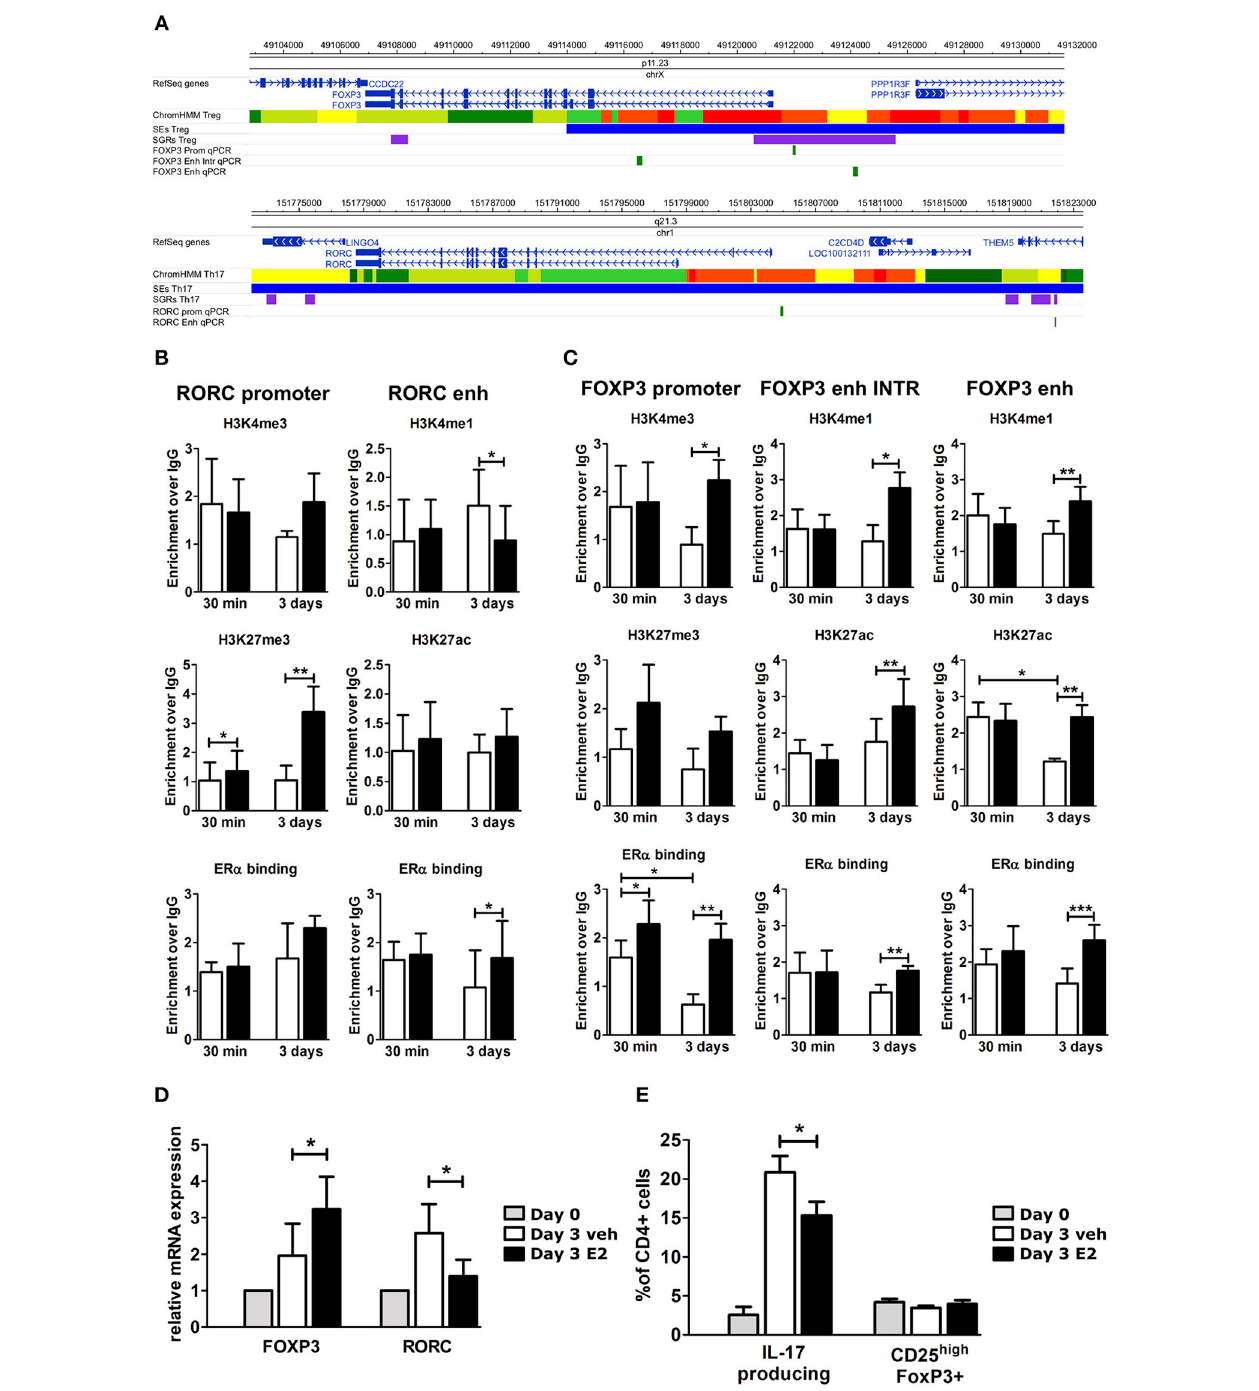
FIGURE 3 | E2 impairs Th17 polarization inducing chromatin remodeling at CSRs. (A) UCSC Browser of human FOXP3 locus and RORC locus. First colored bars represent the chromatin states (e.g., yellow segments are classified as active enhancers). Blue bars are predicted SEs, purple bars are ARRs and green bars are the regions that we analyzed. (B–E) PBMCs from five HD were polarized under Th17 polarizing conditions with or without E2 treatment. ChIP-qPCR analysis of H3K4me3, H3K27me3, H3K4me1, H3K27ac, and ER α at RORC- (B) and FOXP3- (C) CSRs. Columns represent the enrichment of the immunoprecipitation over non-specific IgG and normalized for input chromatin at 30min and 3 days of stimulation. FOXP3 and RORC mRNA expression (D) , and FACS analysis of Th17 and Treg cells in CD4_lymphocytes (E) stimulated for 3 days. * p < 0.05, ** p < 0.01, and *** p < 0.001 represent the statistical significance.